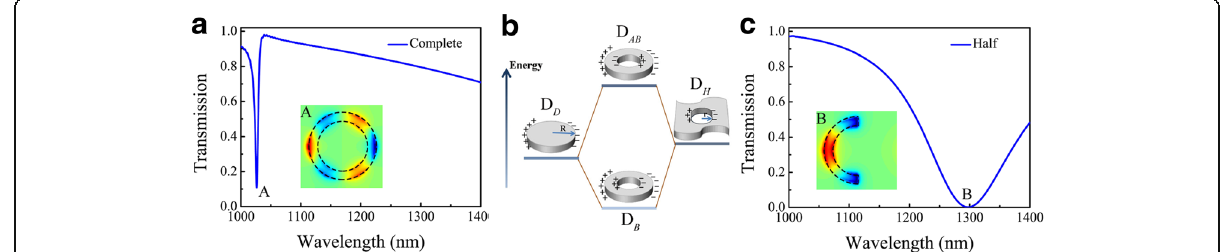
Fig. 2 a Transmission properties of spectra of complete nanoring alone. The distribution of z -component of electric field at the wavelength of 1027 nm denoted by the inset A. b Mechanism of the plasmonic hybridization between the dipolar modes of the disk (D D ) and anti-dot (hole) (D H ) structures and the energy diagram of the degenerated plasmon bonding (D B ) and antibonding (D AB ) modes. The signs “ + ” and “ − ” represent the positive and negative charges, respectively. c Transmission spectra of the single half nanoring. The distribution of z -component of electric field at the wavelength of 1297 nm denoted by the inset B